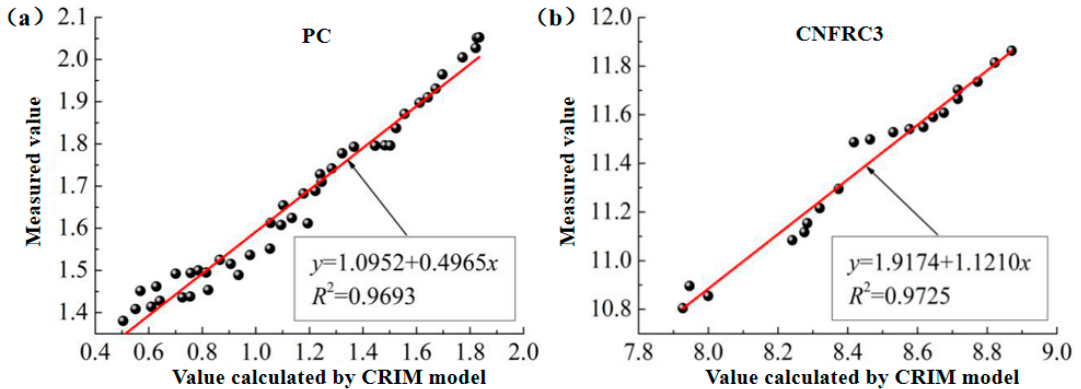
Figure 13. The fitting for relation between measured values and calculated values for ε ,, based on CRIM model. ( a ) PC; ( b ) CNFRC3. (3)